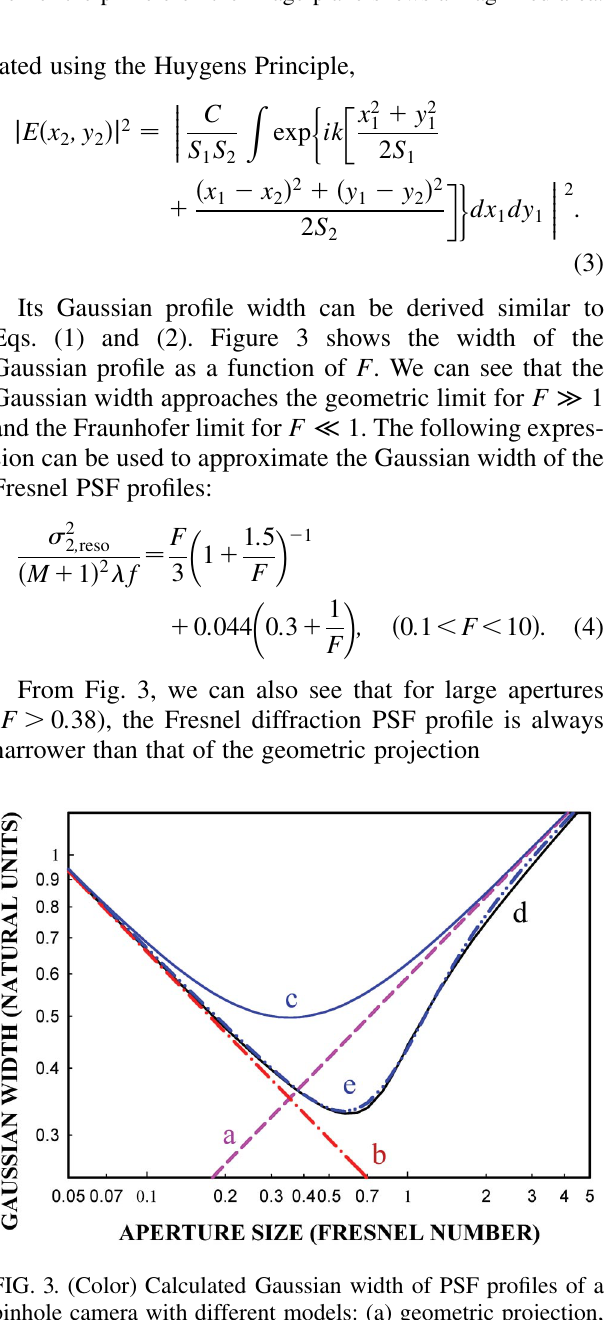
FIG. 2. Schematic of a pinhole camera with a point source. Projection of the pinhole on the image plane shows a magnified